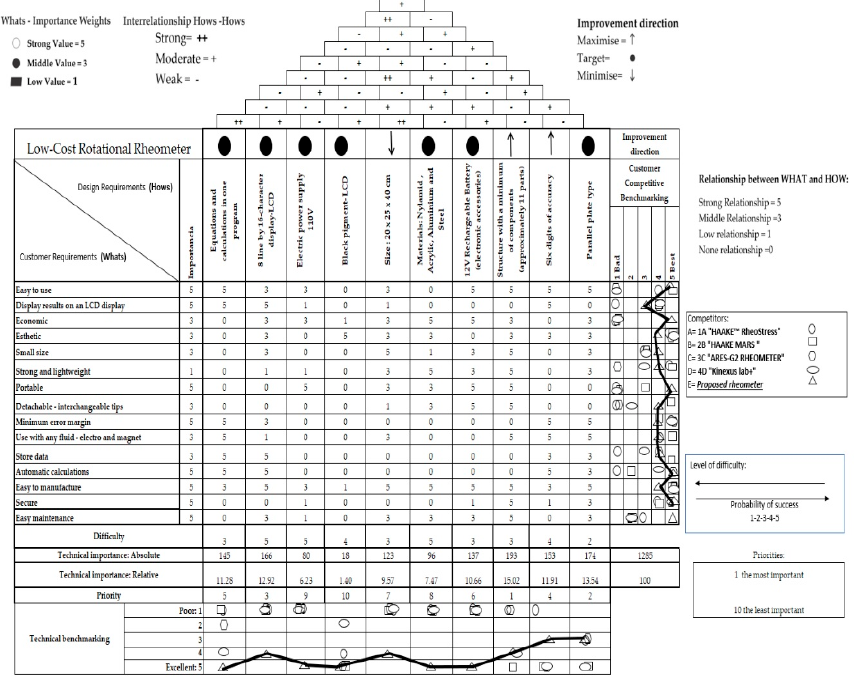
Figure 4. House of Quality (HoQ)—low cost rheometer.